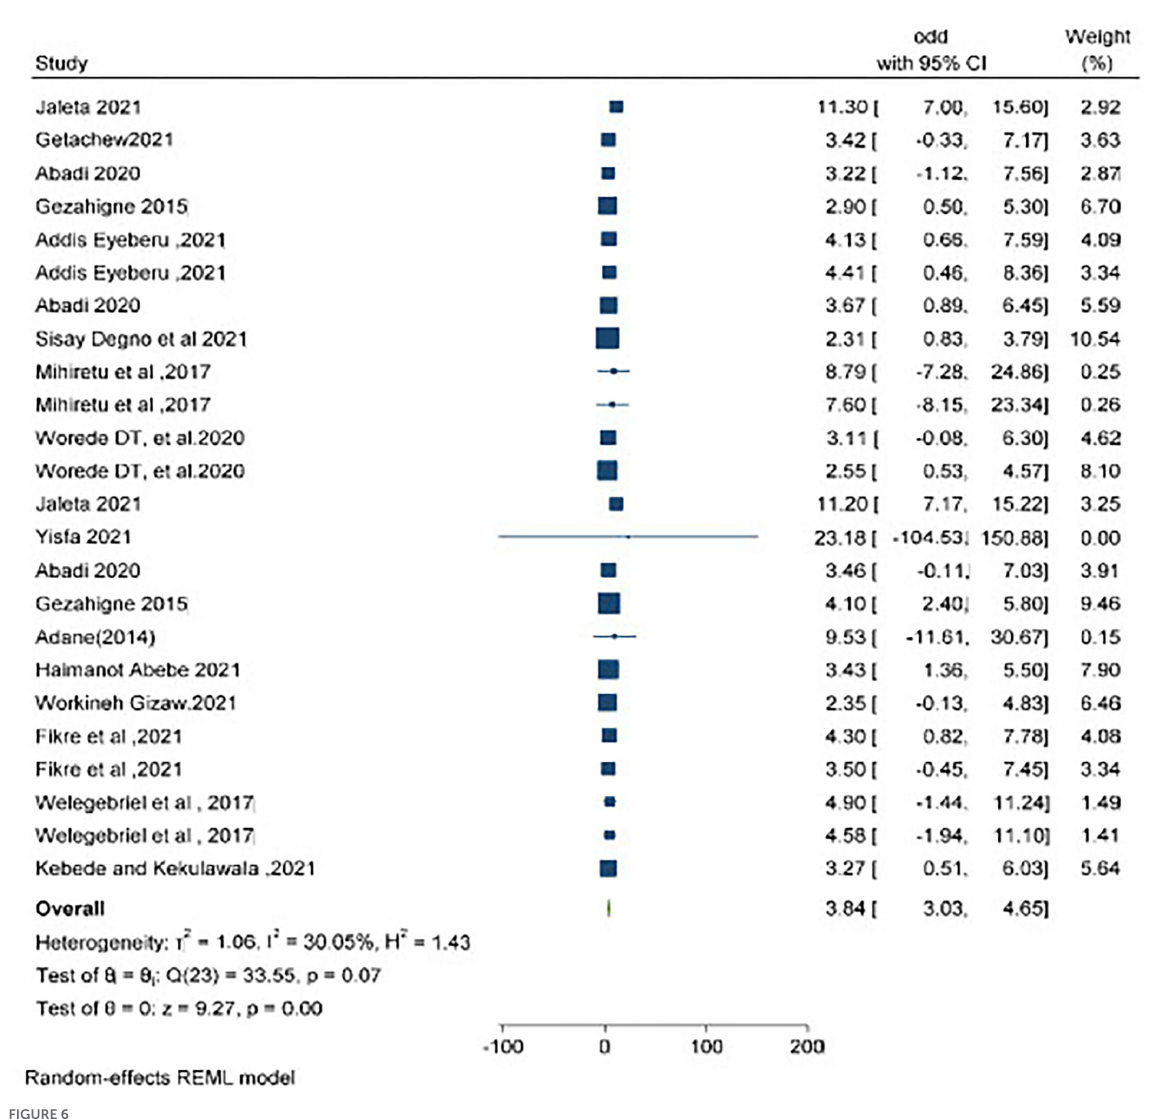
The magnitude of adverse maternal and perinatal outcome